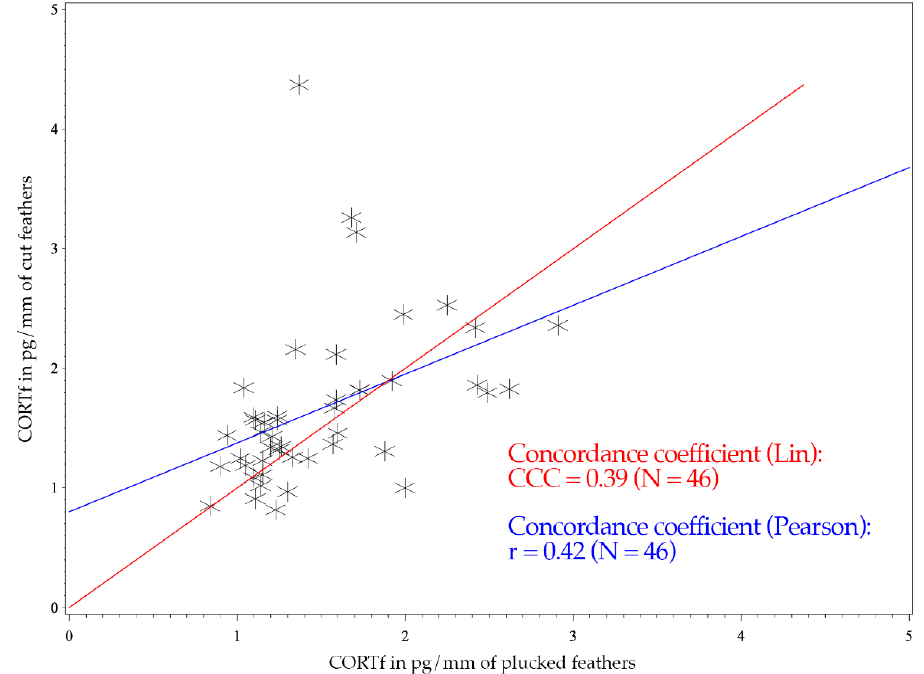
Figure 1. CCC and Pearson’s concordance coefficients of 46 Mallards ( Anas platyrhynchos ). The x -axis shows the CORTf values of plucked feathers in pg/mm, and the y -axis represents the values of cut feathers in pg/mm. The red line illustrates Lin’s concordance coefficient. Pearson’s correlation coefficient is expressed with the blue line.